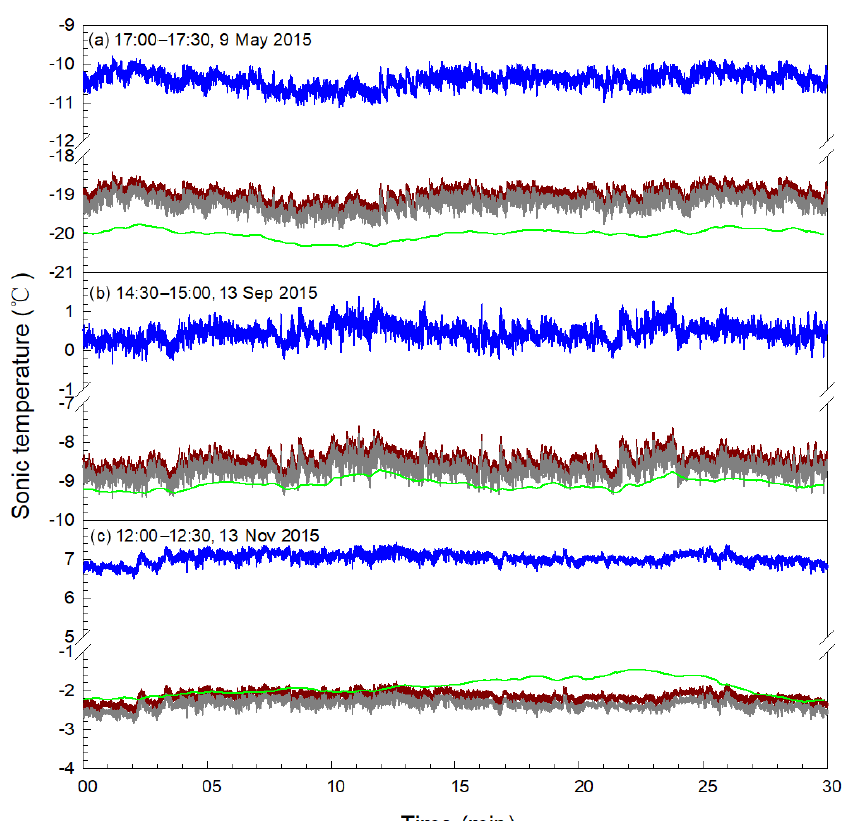
Figure 7. Verification of sonic temperature ( T s ) recovered against calculated (see Appendix D) from the air temperature ( T ) , relative humidity (RH), and atmospheric pressure ( P) that were measured using a HMP155A air temperature and relative humidity probe as well as the IRGASON built-in barometer. Blue curves: T s measured by the IRGASON sonic anemometer in geometrical deformation (raw T s ); red curves: T s recovered from raw T s using Eq. (33); grey curves: T s recovered also from raw T s using Eq. (40) (i.e., adjusted Eq. 33); and green curves: T s calculated from T , RH and P